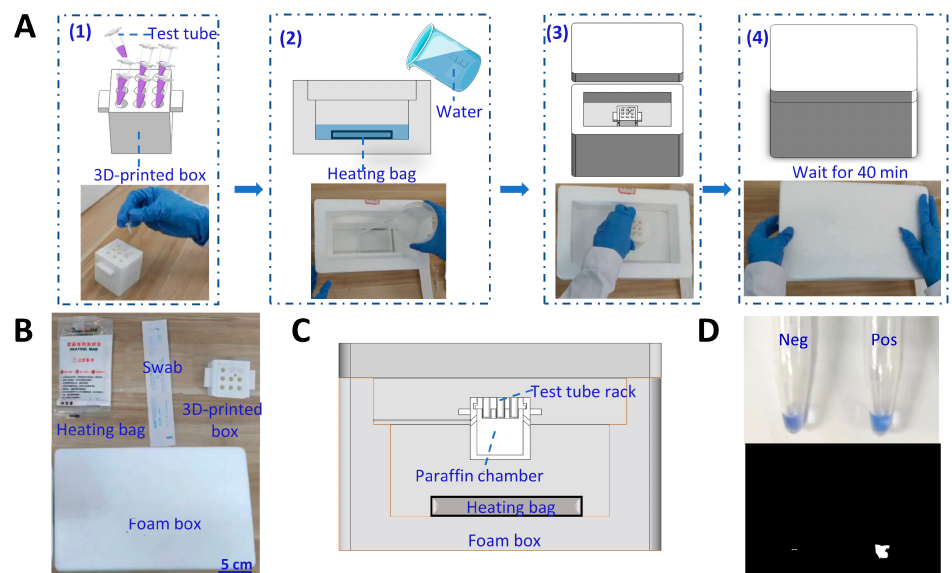
Figure 5. Test protocol and the design of the self ‐ testing system for POCT. ( A ) The self ‐ testing system scheme for performing the detection of SARS ‐ CoV ‐ 2. ( B ) Illustrations of the self ‐ testing system. ( C ) Explored view of the self ‐ testing system. ( D ) The results of the RNA sample extracted from the SARS ‐ CoV ‐ 2 transfected cells by using the self ‐ testing system.